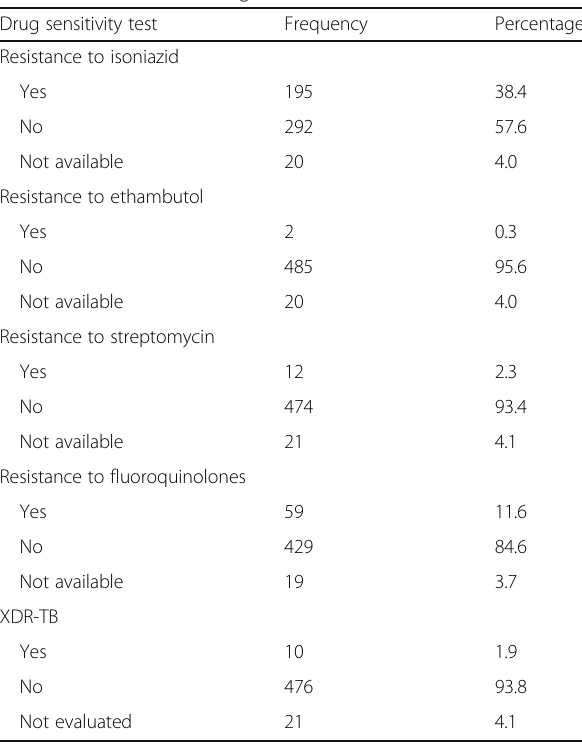
Table 2 Drug sensitivity pattern of DR-TB patients initiated on treatment under the national TB program in three selected districts of Karnataka during 2015 to 2018, N = 507 Drug sensitivity